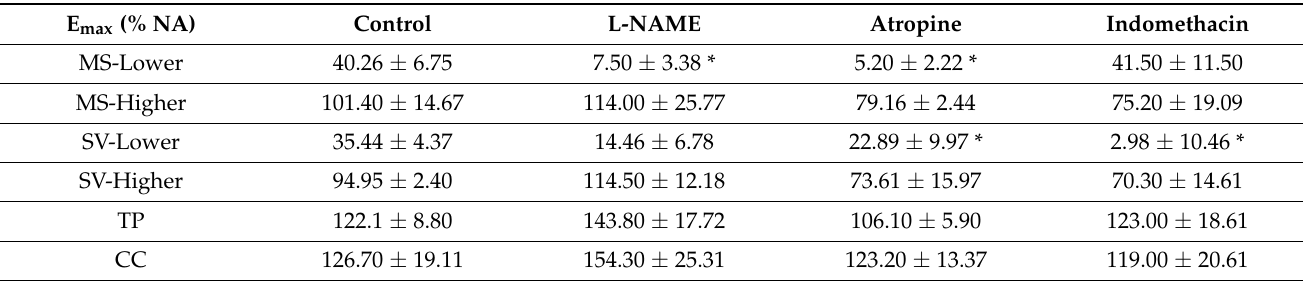
Table 3. Maximum relaxant effect (Emax; %NA) for the four extracts in the absence (control condi- tion) and in the presence of L-NAME 100 µ M, Atropine 6 µ M or Indomethacin 10 µ M, on the rat thoracic aorta.